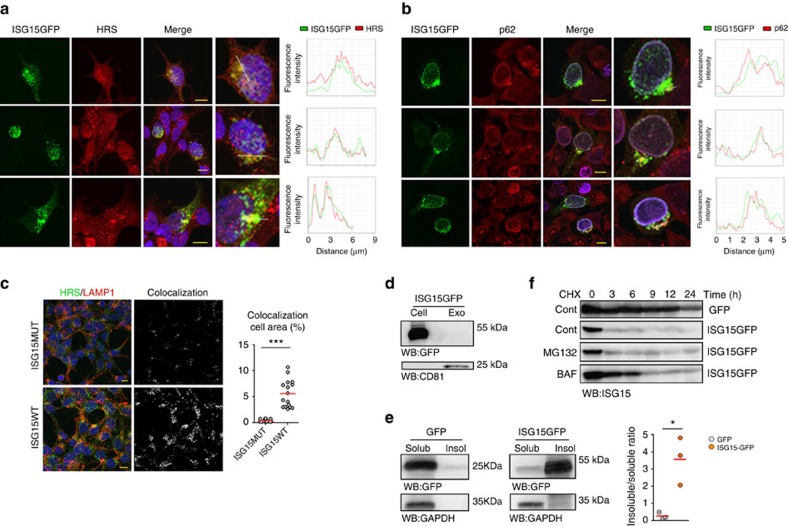
ISG15 conjugation induces protein aggregation and degradation by lysosomes.(a) Confocal co-localization analysis of ISG15-GFP (green) and the MVB marker HRS (red). Right graphs: fluorescence intensity profiles of ISG15-GFP (green) and HRS (red) in the regions delineated by a white line. Nuclei were stained with DAPI. Scale bar, 10 μm. (b) Confocal co-localization analysis of ISG15-GFP (green) and p62 (red). Right graphs represent fluorescence intensity profiles of ISG15-GFP (green) and p62 (red) of the regions delineated by a white line. Nuclei were stained with DAPI. Scale bar, 10 μm. (c) Confocal microscopy analysis of HRS (green) and LAMP1 (red) co-localization in HEK293 cells co-transfected with ISGylation machinery and functional (ISG15WT) or mutated ISG15 (ISG15MUT). Nuclei were stained with DAPI. Scale bar, 10 μm. Co-localization area per cell was quantified by ImageJ (n=16). Each dot represents the percentage of co-localization area per cell surface and mean is indicated in red lines. (d) Western blot analysis of exogenous ISG15 in HEK293 cells transfected with ISG15-GFP. Cells and EVs (EXO) were blotted for GFP and CD81. (e) Western blot analysis of ISG15-GFP and GFP in 0.5% NP-40 soluble and insoluble cell fractions in HEK293 transfected with GFP or ISG15-GFP. Right graph: quantification of GFP and ISG15-GFP in the insoluble fraction respect to the soluble fraction in three independent experiments. (f) Western blot analysis of GFP and ISG15-GFP degradation kinetics in HEK293 cells transfected with GFP or ISG15-GFP and treated with cycloheximide to inhibit protein synthesis during the indicated times. Where specified, the medium was supplemented with the lysosome inhibitor Bafilomycin A1 (BAF) or the proteasome inhibitor MG132. A representative blot from two independent experiments is shown. Data from c,e: t-test *P-value<0.05 and ***P-value<0.0001.